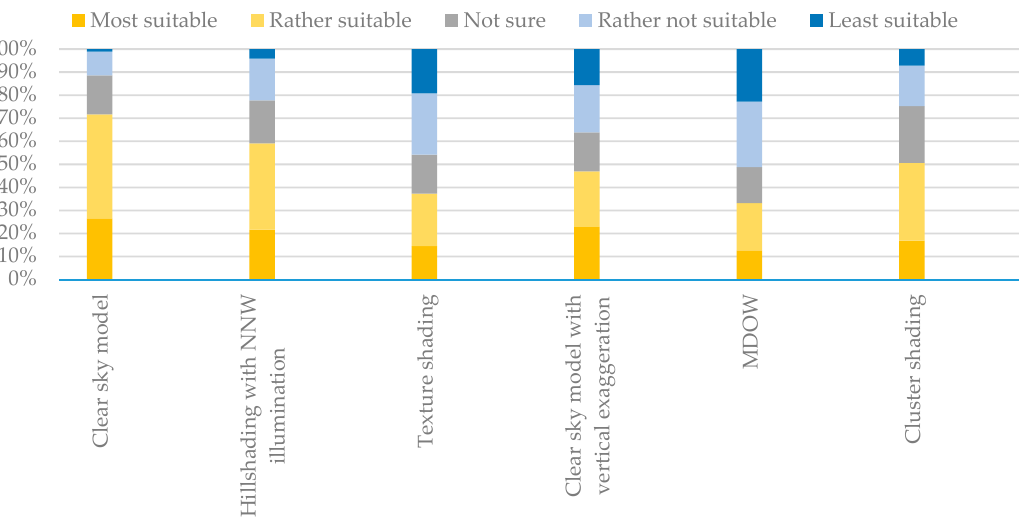
Figure 11. Survey results for plateaus.